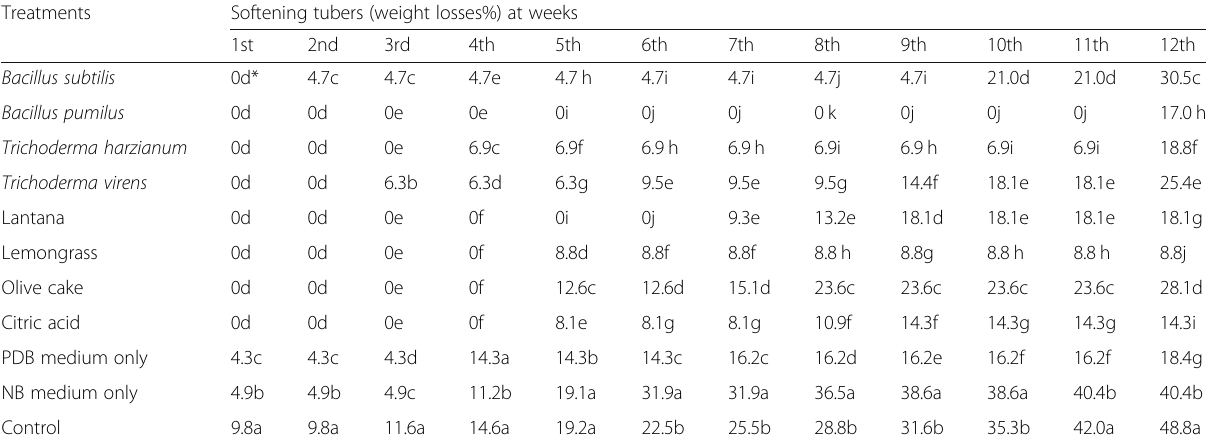
Table 5 Effect of bio-control agents, plant extracts, and citric acid as foliar spray against bacterial soften potato tubers disease (as weight losses %) under storage conditions Treatments Bacillus subtilis